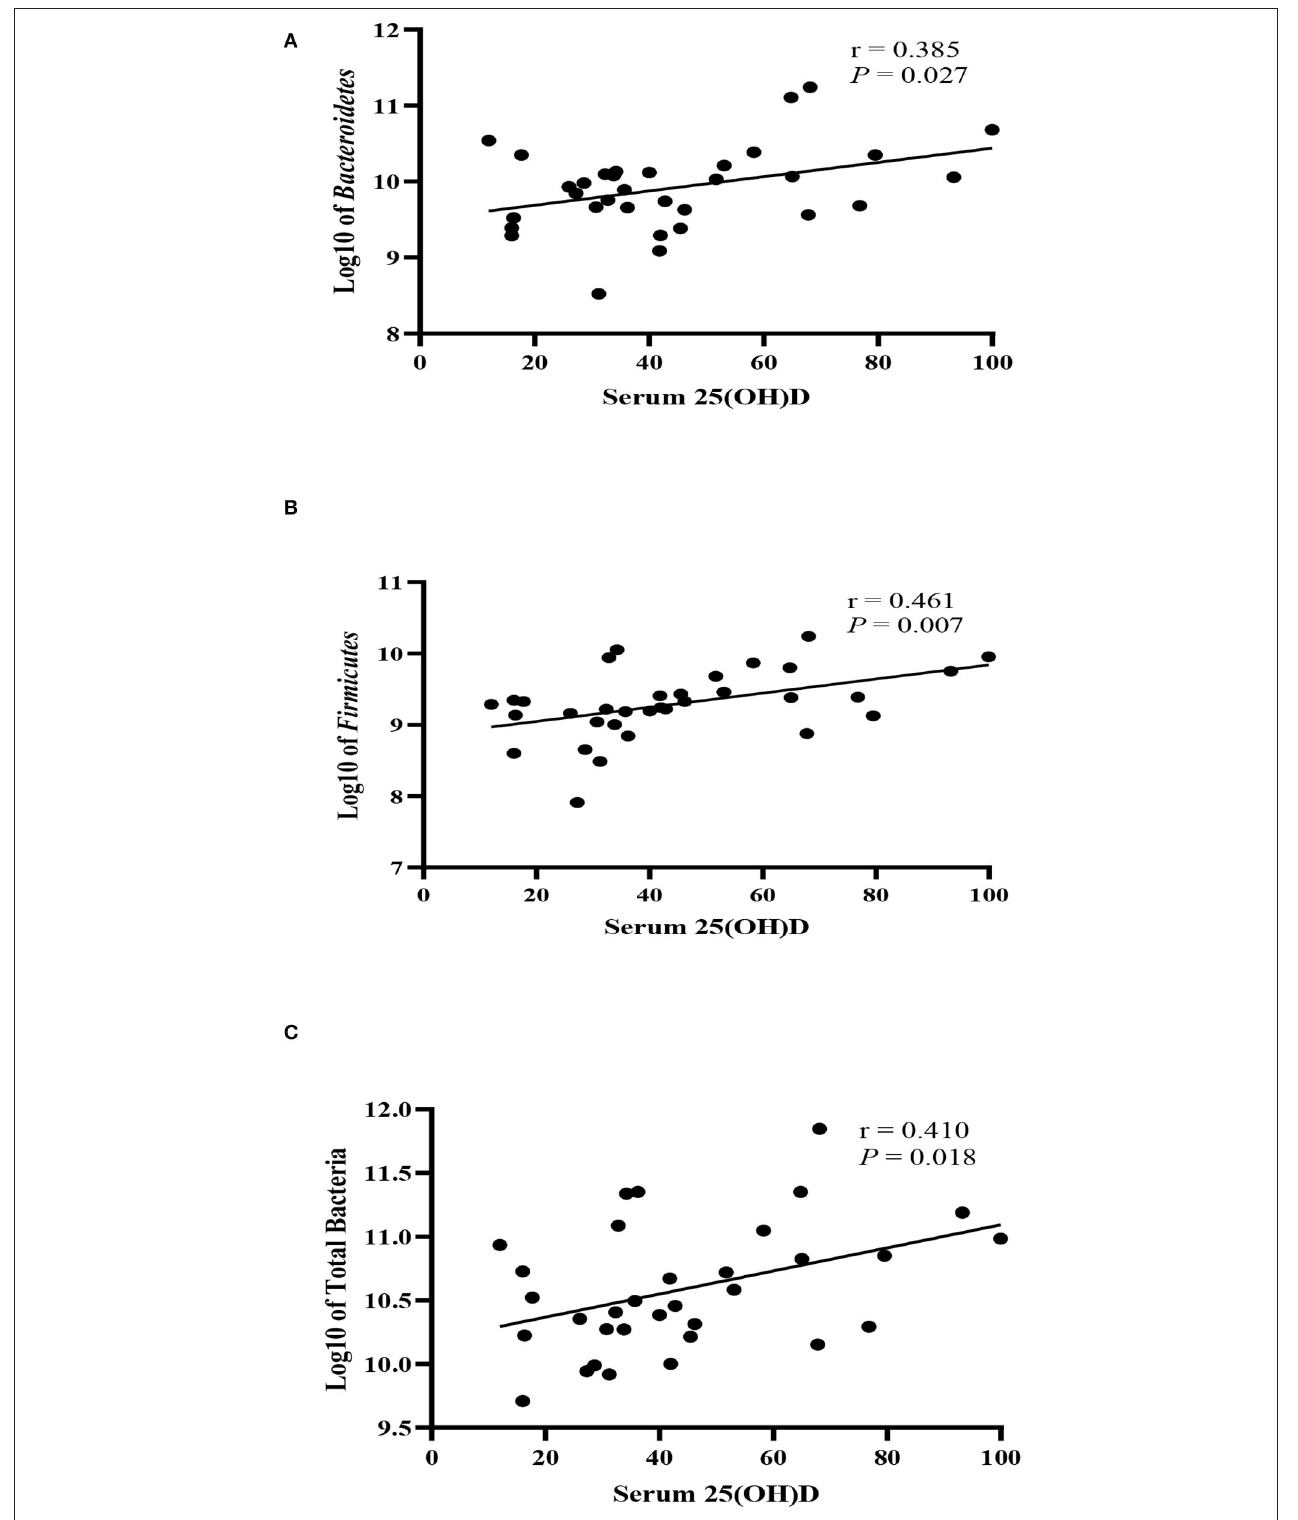
FIGURE 3 | Correlation between fecal bacteria strains and serum 25-hydroxyvitamin D level (nmol/L) in children with CF. (A) Bacteroidetes , (B) Firmicutes , (C) Total bacteria. r denotes Pearson’s correlation coefficient.